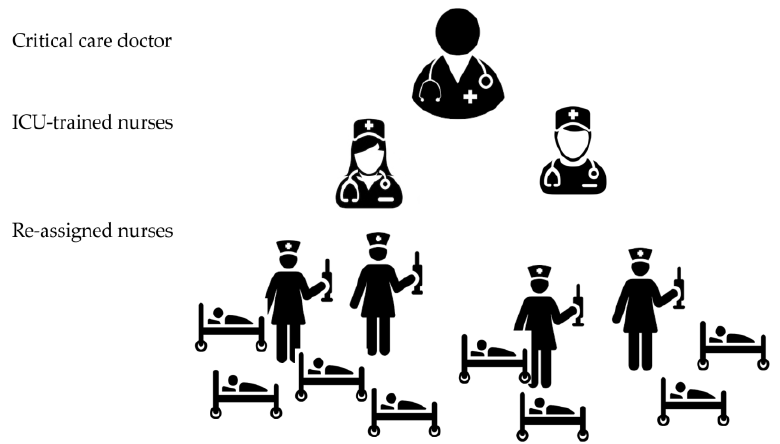
Figure 4. ICU tiered staffing strategy for COVID-19 pandemic; (1 ICU-trained nurse: 2 re-assigned nurses: 4 patients). This model can be expanded on a needs basis as pandemic scales up.